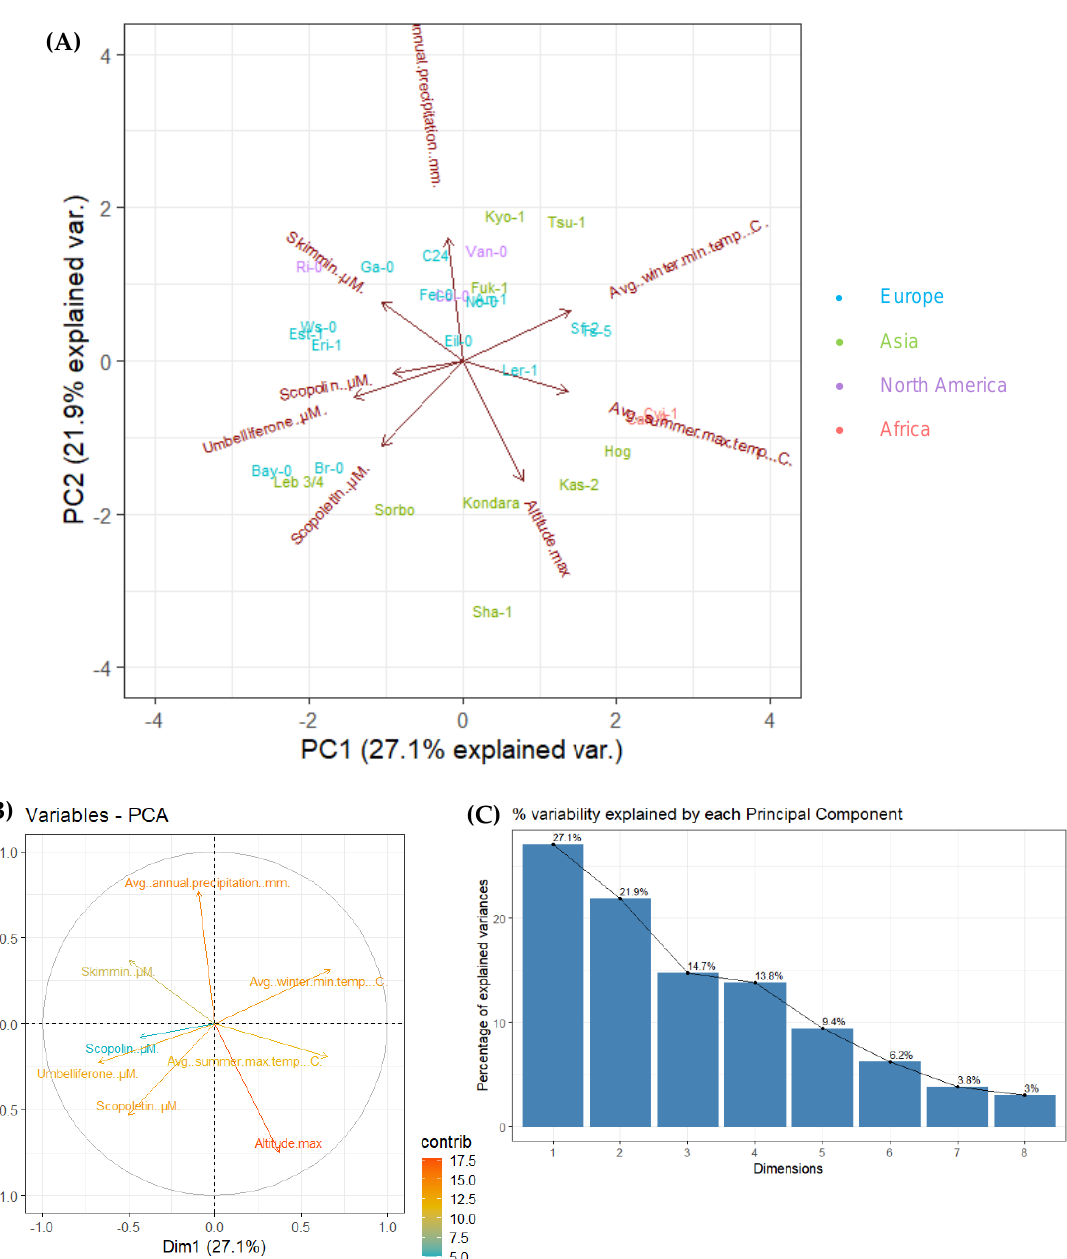
Figure 5. ( A ) Principal component analysis (PCA) for 28 Arabidopsis accessions using the concentration of umbelliferone, scopoletin and their corresponding glycosides (skimmin and scopolin, respectively) in root samples without hydrolysis, and four geographic and climatic factors (maximal altitude [m], average winter minimal temperature [ ◦ C], average summer maximal temperature [ ◦ C] and average annual precipitation [mm]; Table S4). Factor coordinates are marked with arrows. Observations indicated by blue accession names represent European locations (n = 14), green represent Asian locations (n = 9), violet represent North American locations (n = 3) and red represent African locations (n = 2). The abbreviations indicate the accessions according to Table 2. Component one and two explain 49% of the point variability. ( B ) The Variables-PCA contribution plot shows the correlation of the variables used in PCA with the respective contribution of each factor (contrib) indicated with a colour gradient. ( C ) The scree plot/graph of variables demonstrate the percentage of variability explained by each dimension (PC). Principal Component 1 and 2 explain 27.1% and 21.9% of the variance respectively. A negative correlation is highlighted between the following variables: (1) umbellifer- one concentration and temperatures (average winter minimal temperature and average summer maximal temperature); (2) scopolin concentration and temperatures